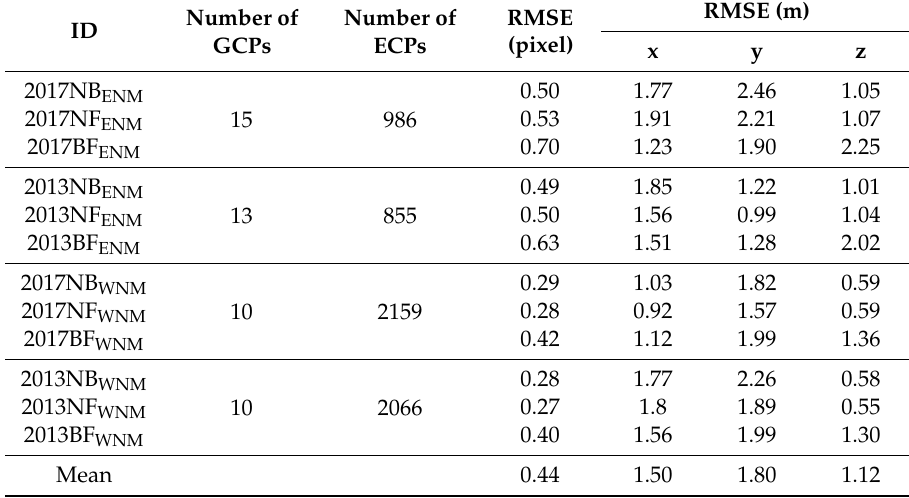
Table 2. Triangulation information for all image view angle combinations in ERDAS IMAGINE 2015. ID is expressed by year, view angle combination and study area (ENM or